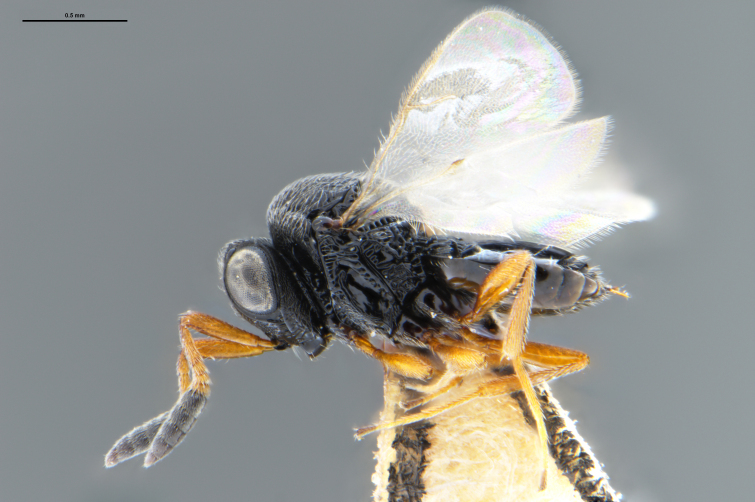
lateral habitus